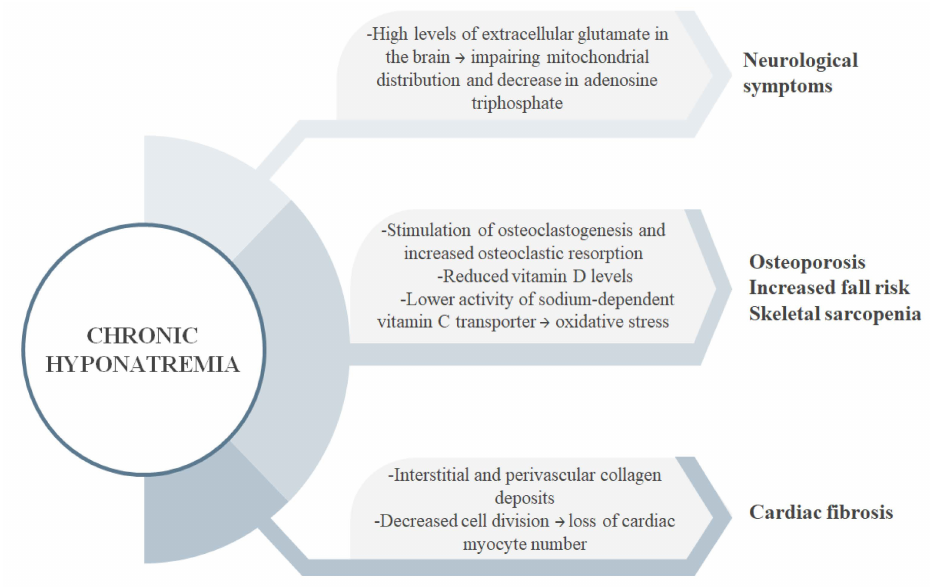
Figure 2. Effects of chronic